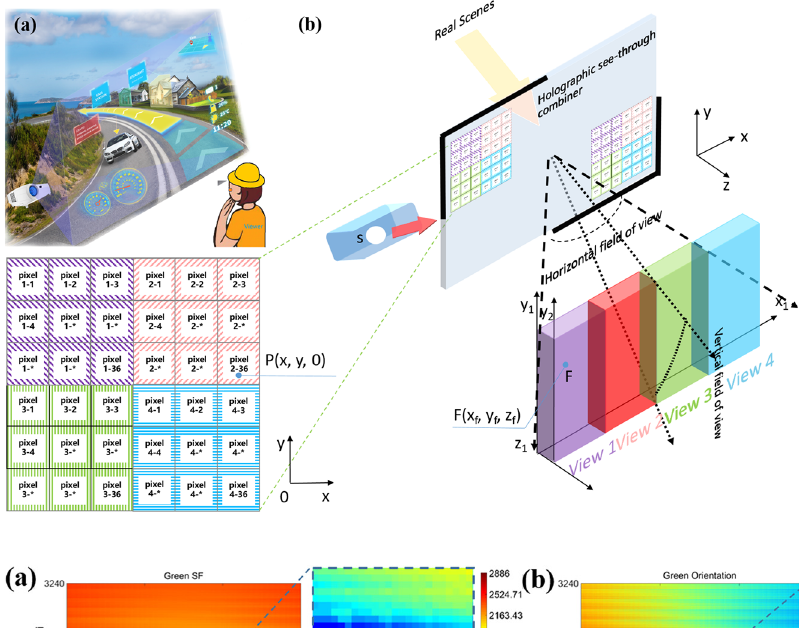
Figure 1: The schematic diagram of the glasses-free augmented reality 3D display. (a) Schematicdiagram of the AR 3D display. (b) Schematic of the multiview 3D display based on the holographic see-through combiner with 16-view horizontal parallax (four are shown in the figure). Each pixel contains 36 metagratings.